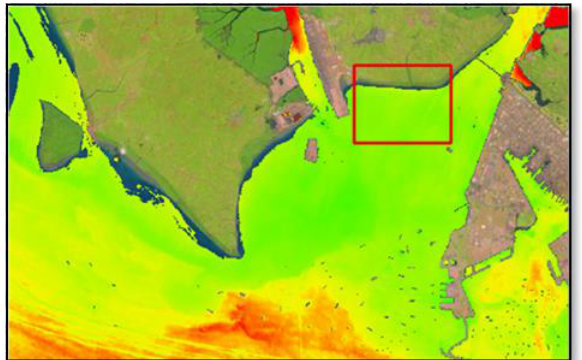
Figure 9. Overview imagery-derived bathymetric model from Stumpf et al’s band ratio approach.